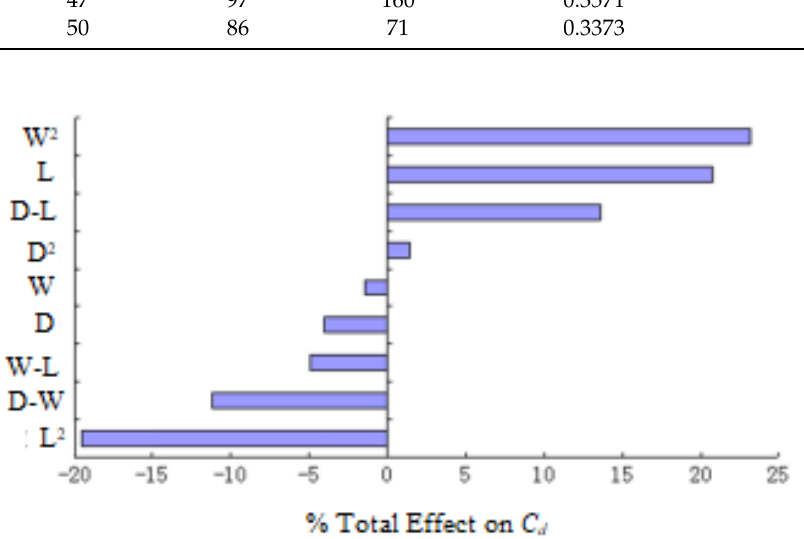
Figure 8. Pareto chart of C d for minivan with circular concave non-smooth surface. Figure 8 shows that the longitudinal distance L has the greatest impact on aerodynamic drag coefficient C d , the effect of which on C d is about 22%. The diameter D and the lateral distance W have the reverse trend of effects, 2% and 4%, respectively, and so the longitudinal distance L is the major factor affecting the aerodynamic drag coefficient. The interaction effect between design variables is shown in Figure 9. The unit of horizontal coordinate in Figure 9 is